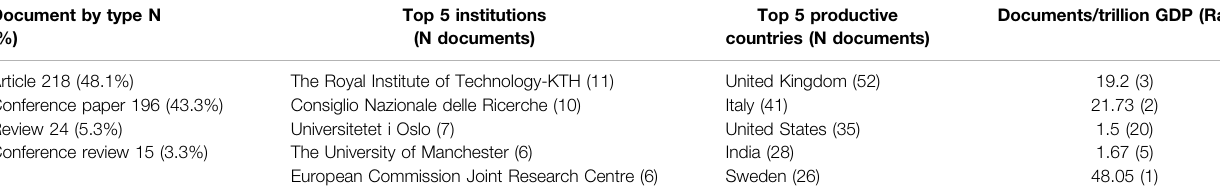
TABLE 1 | Descriptive characteristics of manuscripts indexed in the Scopus database. Document by type N (%)